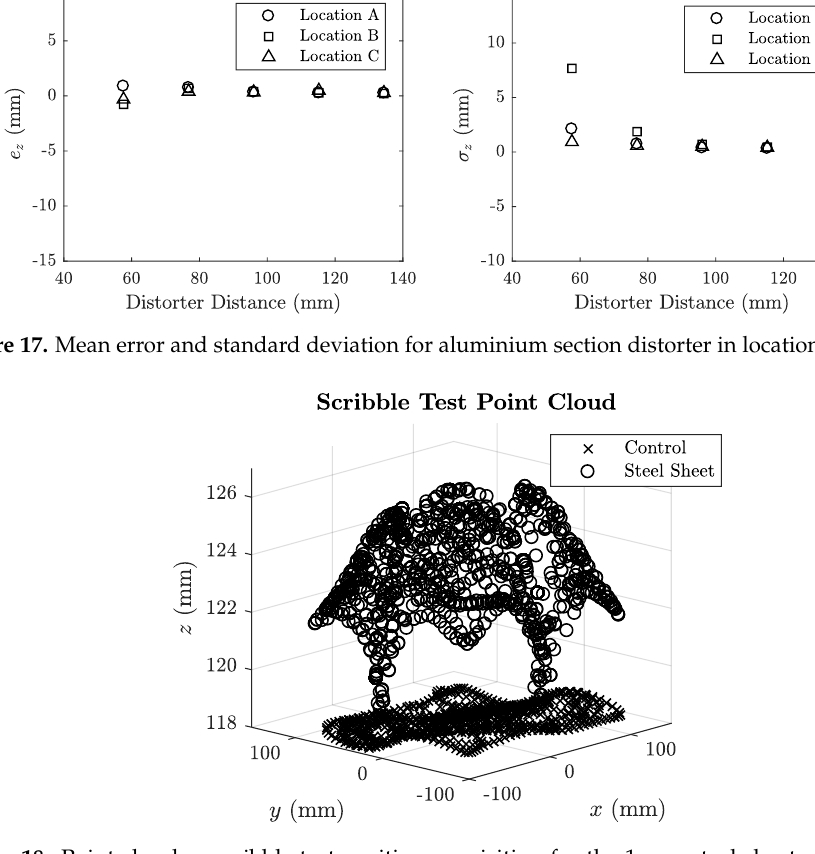
Figure 18. Point clouds a scribble test position acquisition for the 1 mm steel sheet placed 57 mm below the transmitter PCB. The point cloud with steel present has a mean height of ¯ z steel of 129.5 mm = 7.46 mm. The control point cloud is also shown for reference and large standard deviation of σ z steel = 0.37 (¯ z control = 118.5 mm, σ z control